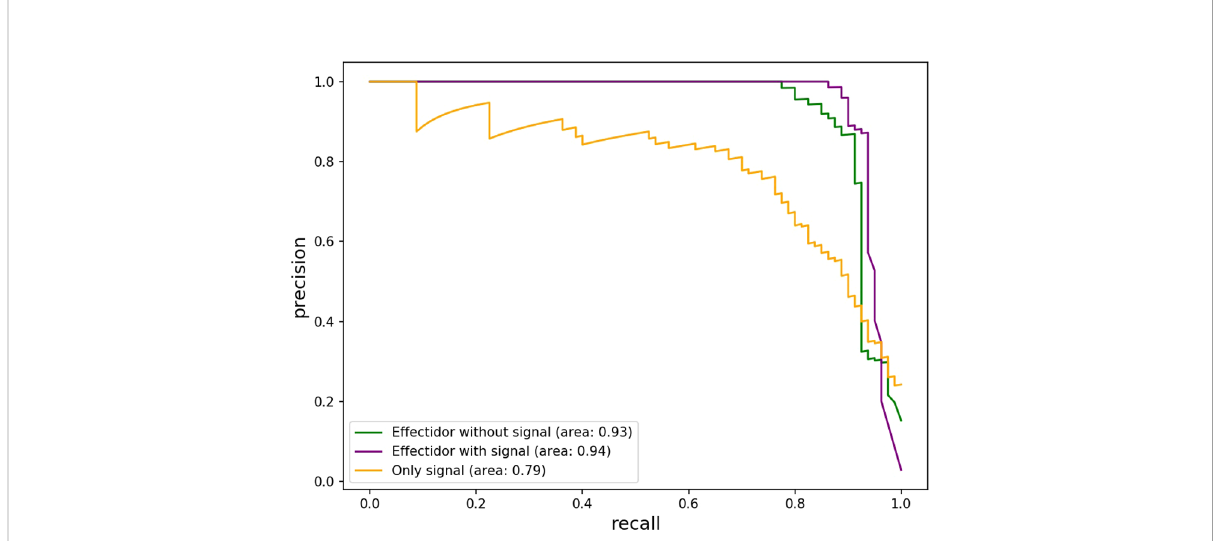
FIGURE 4 Precision-Recall Curves of predicting T3Es in R. solanacearum GMI1000 based on the secretion signal feature as a sole feature, and based on the predictions of Effectidor, with and without the inclusion of the secretion signal